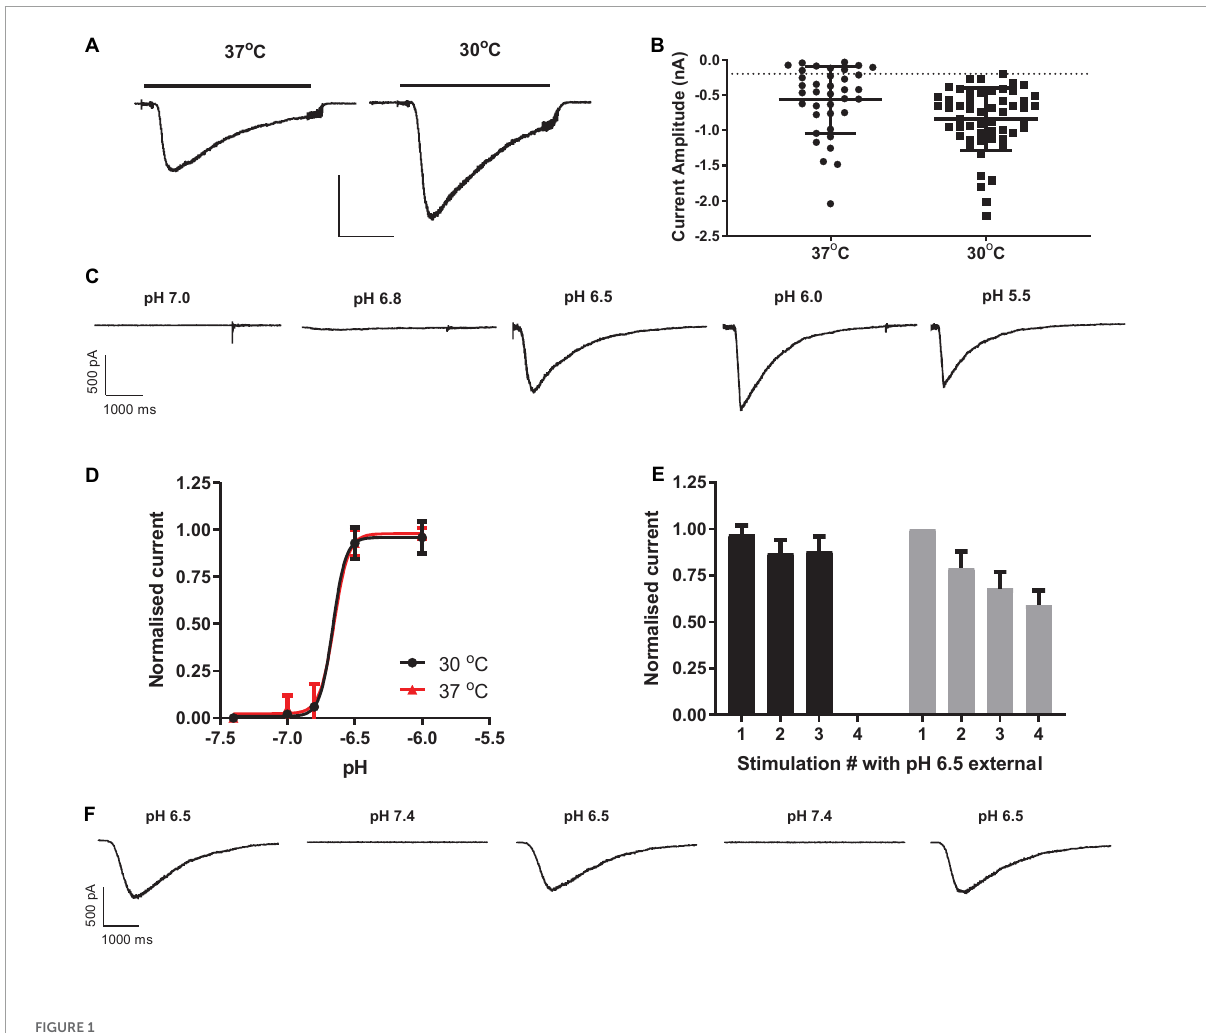
FIGURE1 Properties of endogenous proton-activated currents in HEK cells on QPatch 48 APC platform. (A) Ligand-gated current responses in cells grown at 37 ◦ C or 30 ◦ C, showing rapid activation by pH 6.5 solution application (solid bar) followed by slower desensitization and then more rapid wash-off. Scale bar 0.5 nA and 1 s. (B) Current amplitude distribution in HEK cells grown at 37 ◦ C ( n = 37) and 30 ◦ C ( n = 53). Mean ± S.D shown by black line and error bars, and minimum current amplitude of –200 pA as dashed line. (C) pH-dependency of endogenous proton-activated currents demonstrated by a series of inward current traces in response to rapid application of solutions of increasing acidity. (D) Average pH EC 50 curves from HEK cells grown at 37 ◦ C or 30 ◦ C (mean ± S.D, n = 18 and 26, respectively). (E) pH-activated currents in HEK cells grown at 37 ◦ C are relatively stable during repeated pH 6.5 stimulation (black bars) but exhibit rundown in cells grown at 30 ◦ C to boost current expression (gray bars). Mean ± S.D for n = 7 and 11 cells, respectively. (F) Stability of inward currents in a HEK cell grown at 37 ◦ C during repeated pH 6.5 stimulation, interspersed with application of control pH 7.4